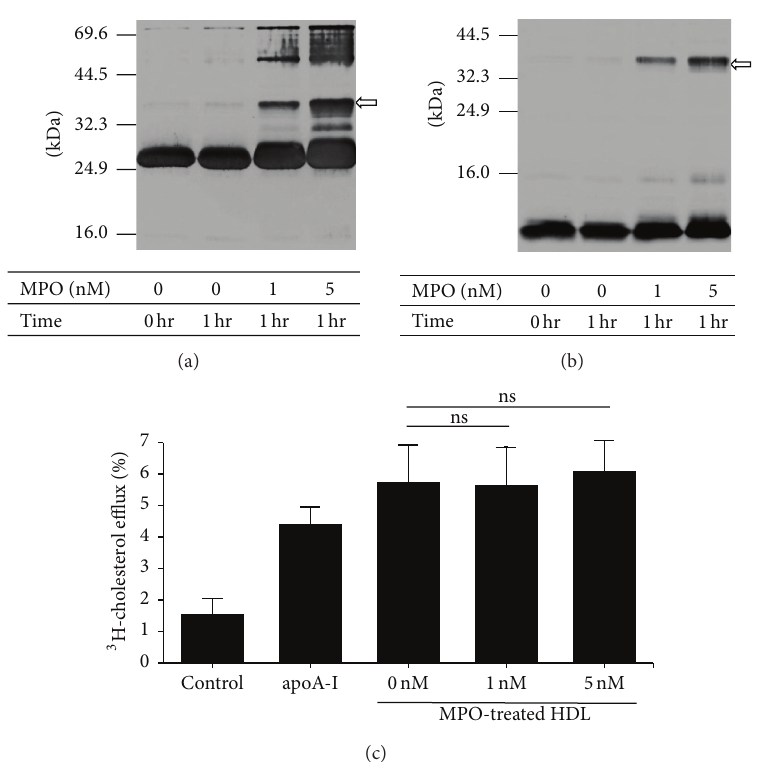
Figure5:EffectsofMPOtreatmentonHDLcholesteroleffluxcapacity.apoA-I/apoA-IIheterodimerformationisinducedbyMPOoxidation. HDLtreatedwithMPO(0,1,or5 nM)for1hrwassubjectedtoSDS-PAGEfollowedbyimmunoblottingforapoA-I(a)andapoA-II(b).Arrows indicate the apoA-I/apoA-II heterodimer. Molecular masses of the standards are listed on the left. The amount of protein was 3 𝜇 g/lane. [ 3 H]- labeled cholesterol-loaded THP-1 macrophages were cultured in medium containing 50 𝜇 g/mL HDL treated with 0, 1, or 5 nM MPO for 1hr. Cholesterol efflux was determined after 4hrs of incubation. Efflux media without HDL and with apoA-I (10 𝜇 g/mL) were used as a negative control and for comparison, respectively. Results are means ± SD of three independent experiments. ns: nonsignificant.